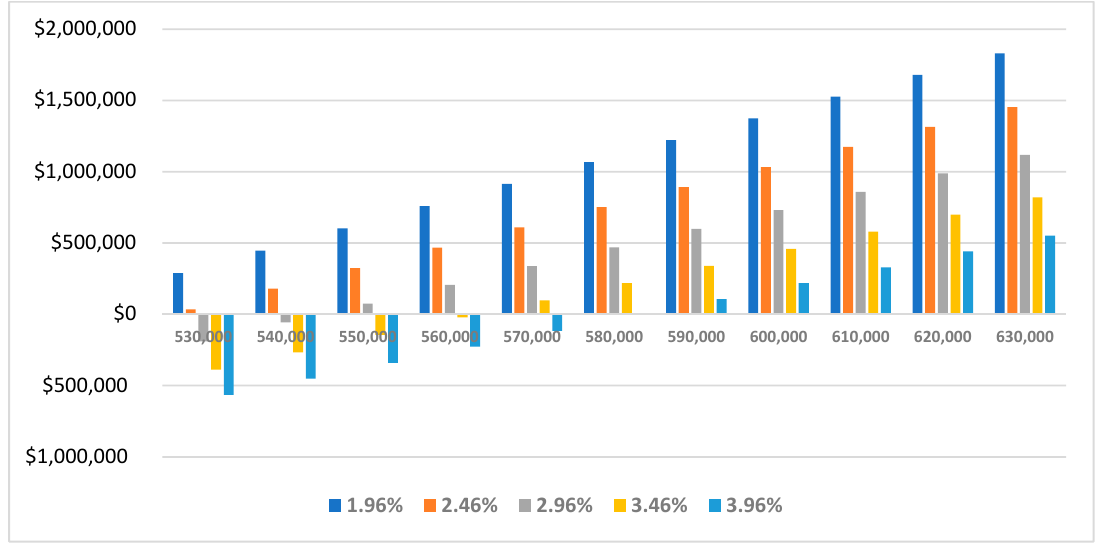
Figure 3. NPV of social discount rate changes in 9 berths.